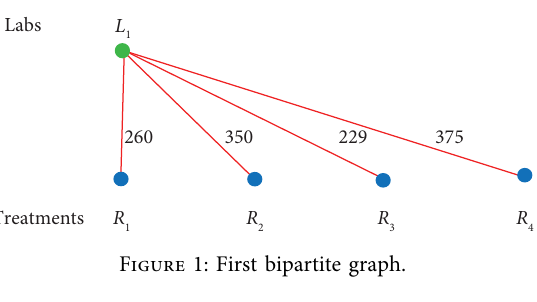
Figure 1: First bipartite graph.